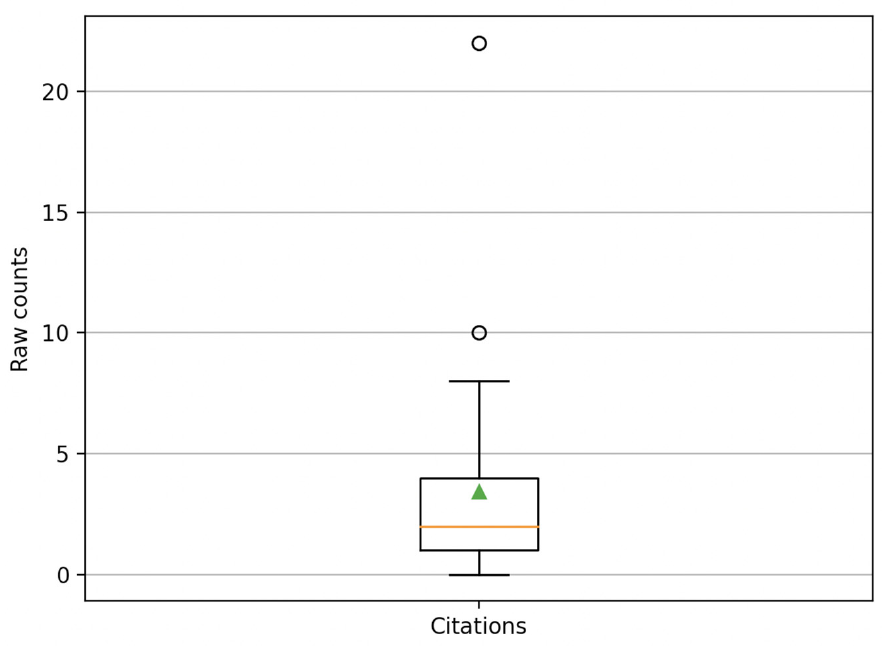
Figure A6. Research papers associated with JOHD/RDJ data papers: average total citation counts. Citations of research papers with an associated data